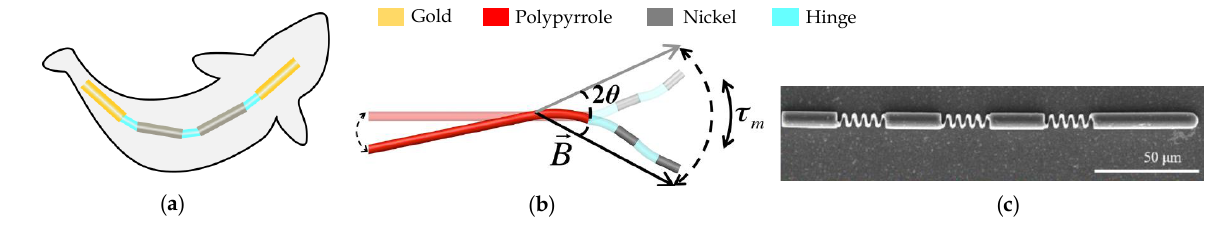
Figure 8. Nanowires for locomotion: ( a ) Nanoswimmer which uses two gold segments to mimic the head and caudal fin of the fish; ( b ) nanoswimmer which uses one PPy segment as the tail [113]; ( c ) four link hydrogel-based biodegradable microrobot which uses microsprings [114].